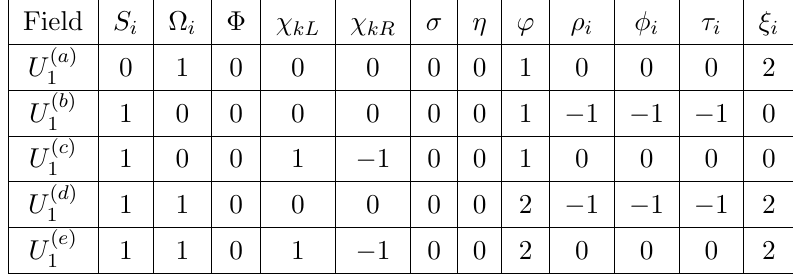
Table 5 . Accidental U (a)